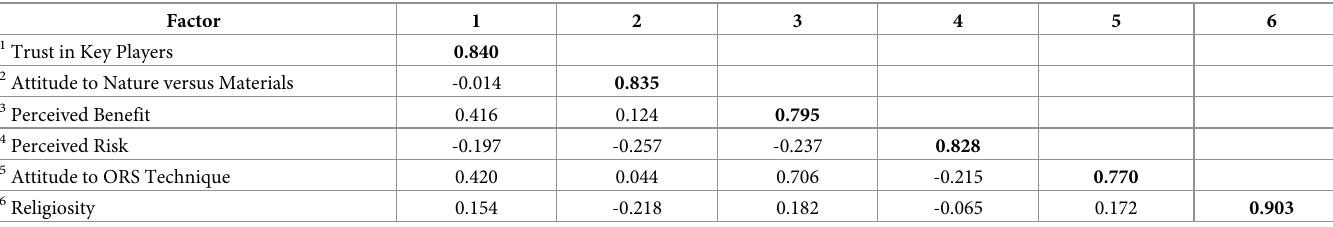
Table 4. Fornell-Larcker Criterion Correlation. Factor